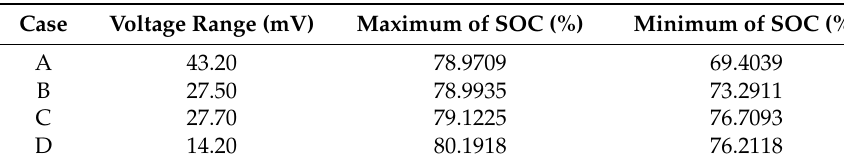
Table 2. Voltage range and SOC (State of Charge) extremum after charging.